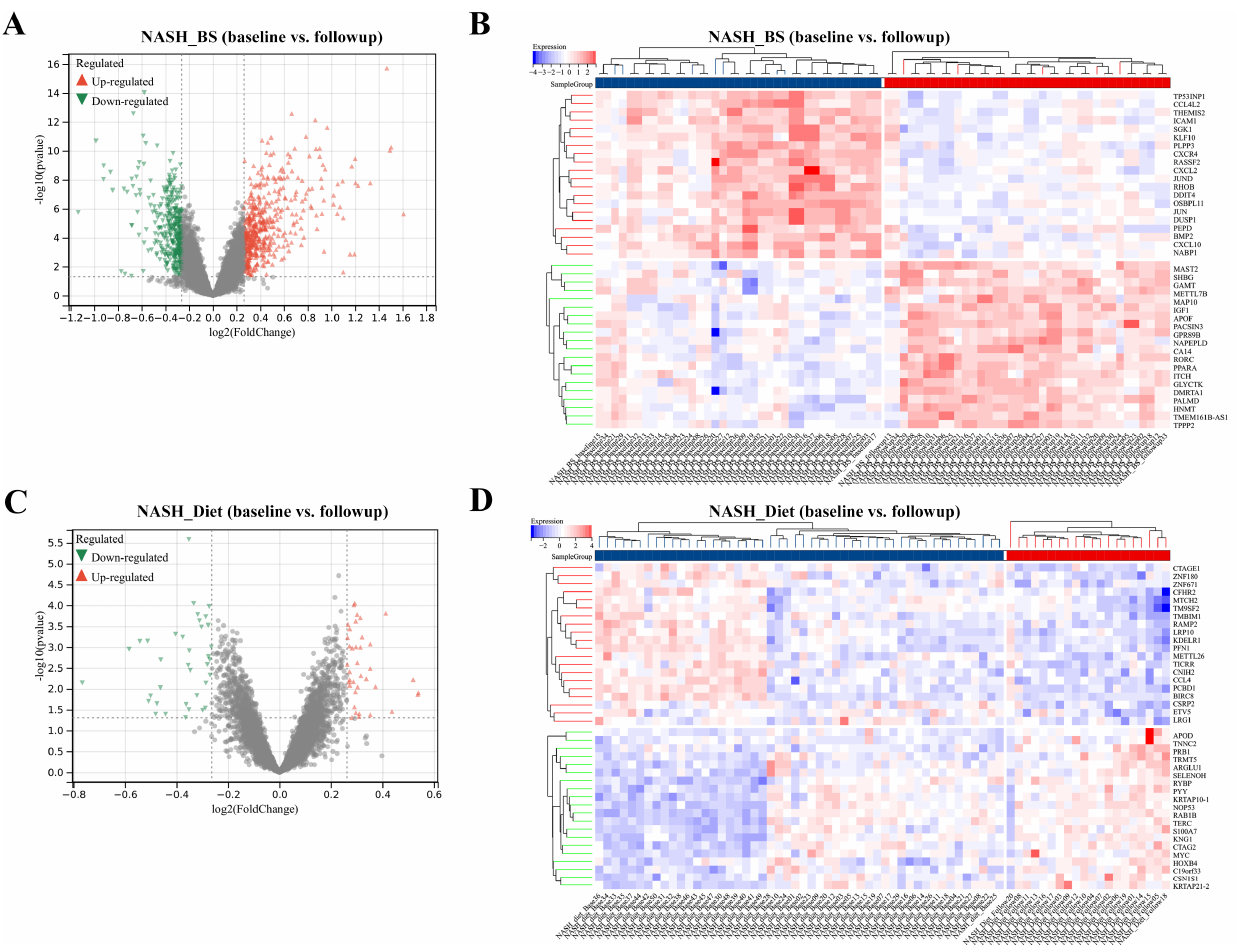
Figure 1. Identification of DEGs. DEGs were screened out from NASH_BS ( A ) and NASH_Diet ( C ) subgroups. The top 20 total significant upregulated and downregulated DEGs were mapped with gene profiles from NASH_BS ( B ) and NASH_Diet ( D ) subgroups.